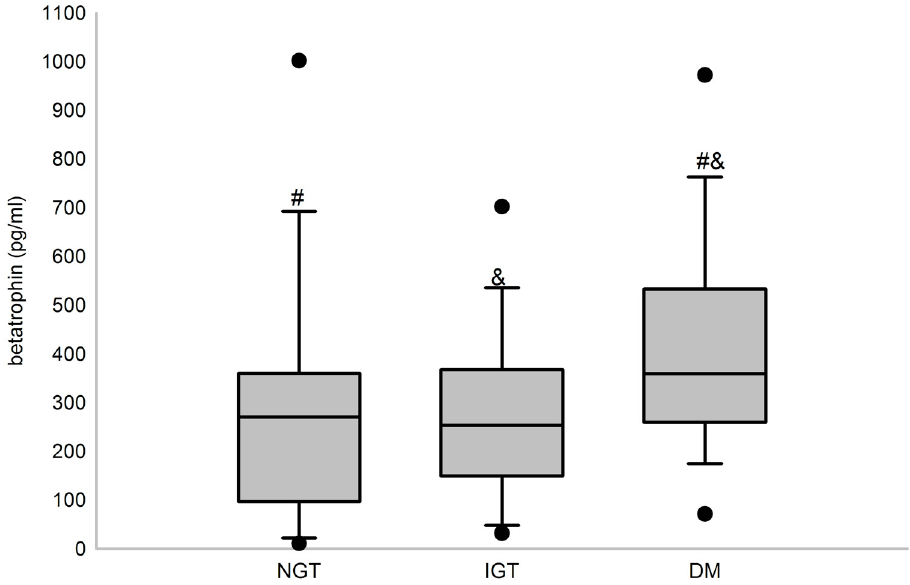
Fig 1. Serum betatrophin levels of subjects with different glucose tolerance statuses. Box plot for serum betatrophin levels in NGT (n = 50), IGT (n = 51) and T2DM (n = 50) subjects. Serum betatrophin levels were significantly different in the three groups ( P < 0.01). #significantly different between T2DM and NGT at P < 0.05 from SNK; &significantly different between T2DM and IGT at P < 0.05 from